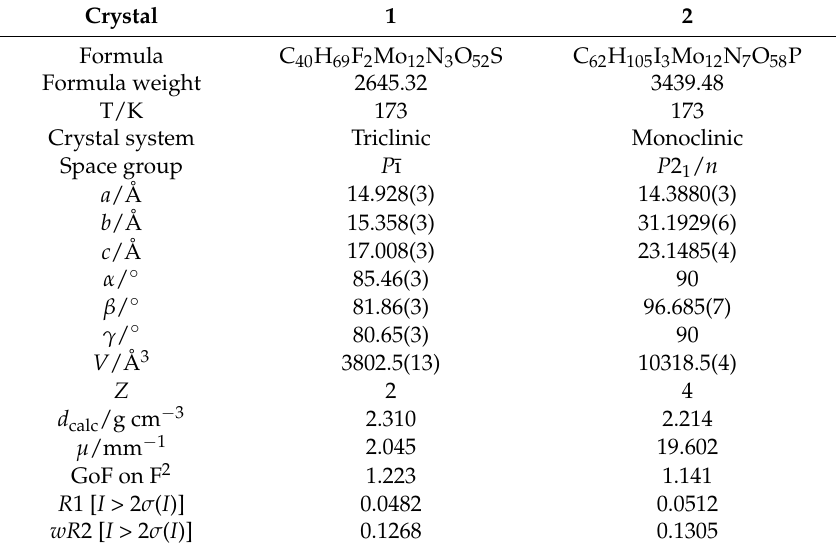
Table 1. Crystallographic parameters for 1 and 2